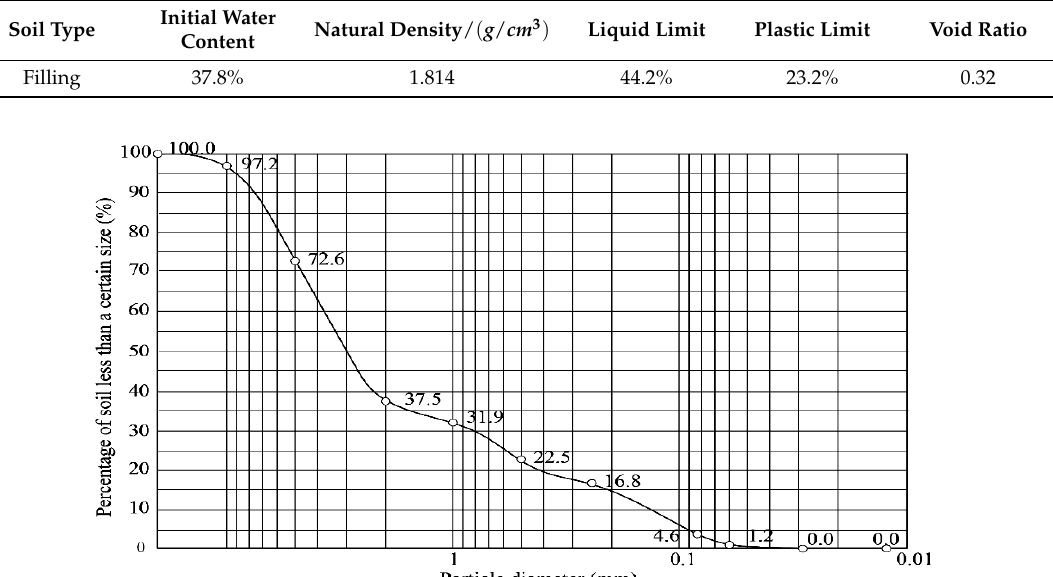
Table 1. Basic physical-mechanical parameters of the soil.